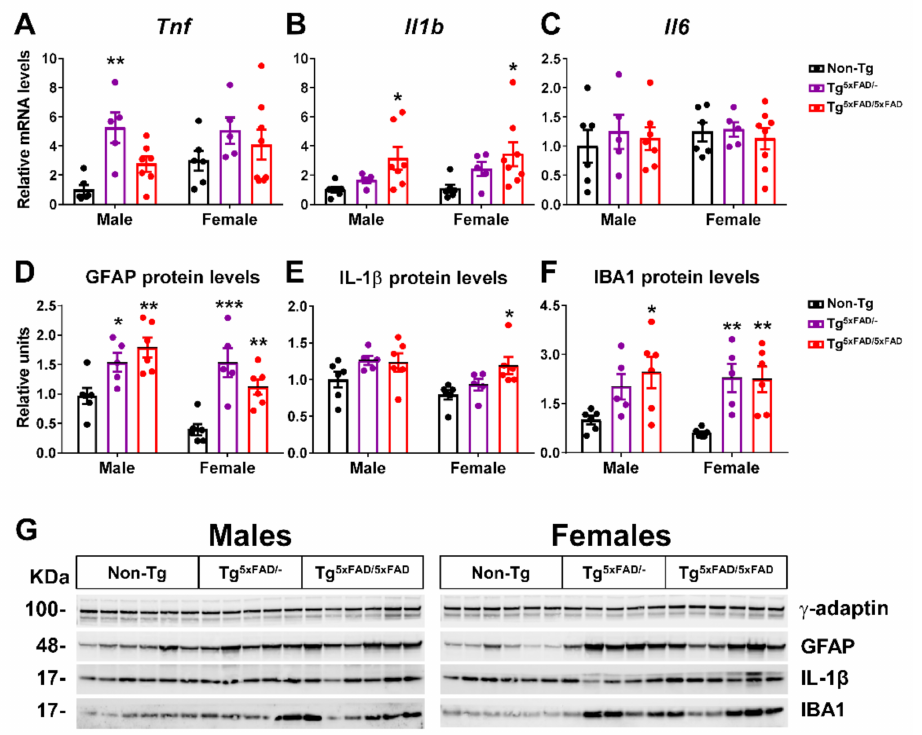
Figure 3. Inflammatory markers were present in the hypothalamus of 5xFAD mice at 6 months